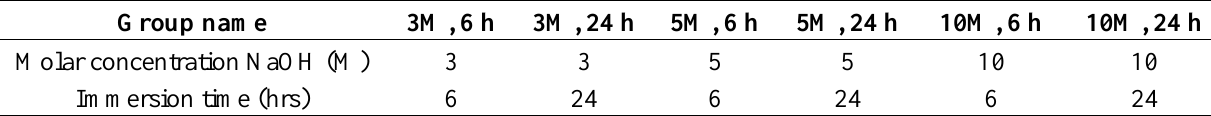
Table 4. Alkali treatment parameters tested during AlAcH